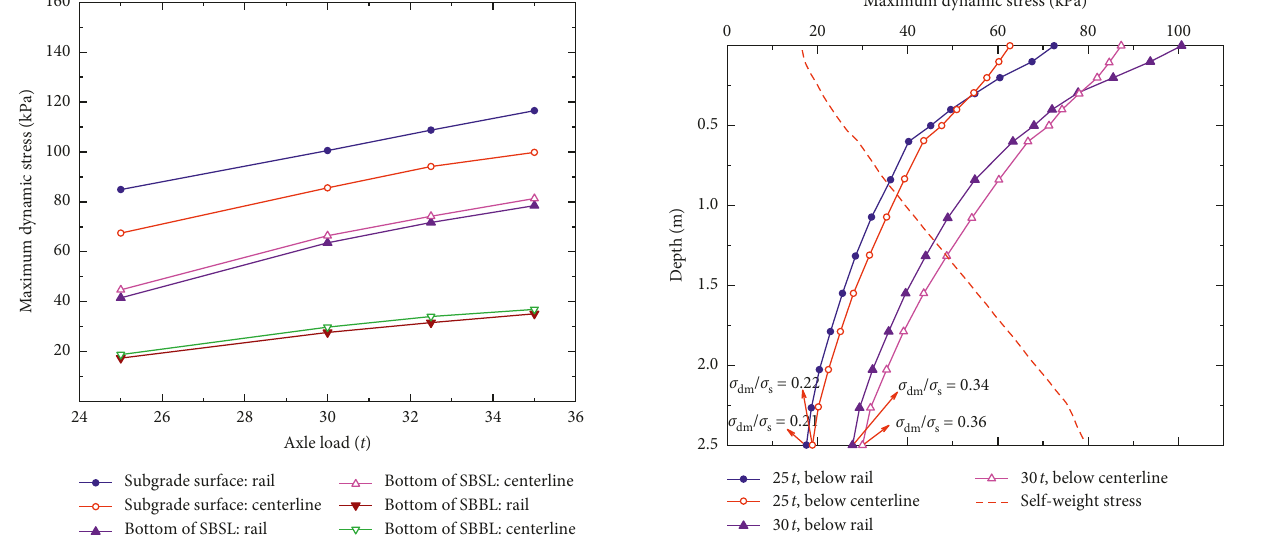
Figure 13: Relationship between the maximum dynamic stress and train axle load.